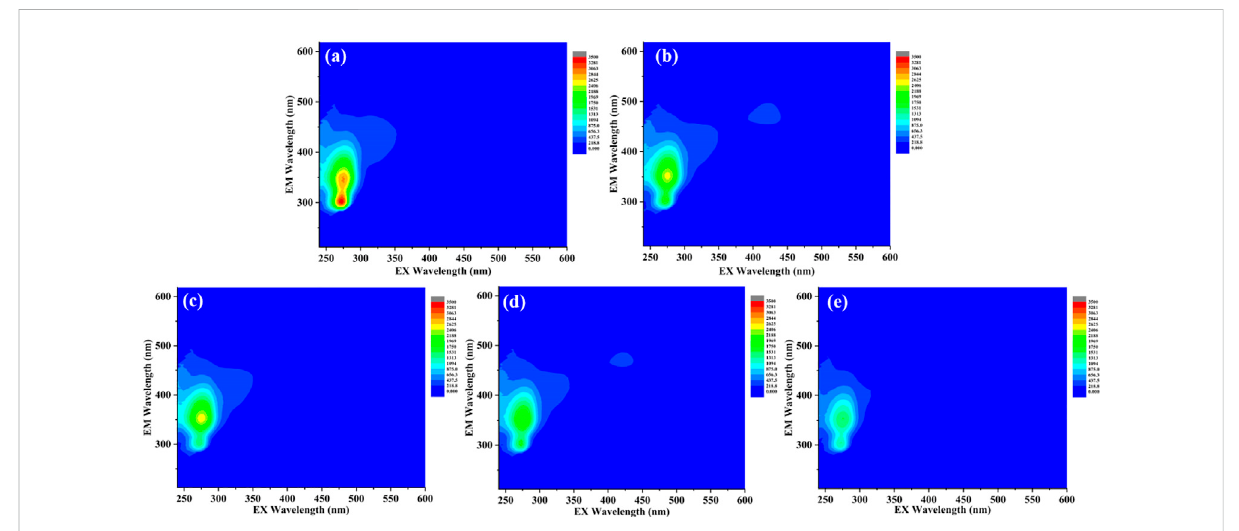
FIGURE 8 EEM spectraof supernatant (A) before the reaction; (B) after the non-seeded reaction; (C) after the struvite-seeded reaction; (D) after the CSB- seeded reaction; and (E) after MFB-seeded